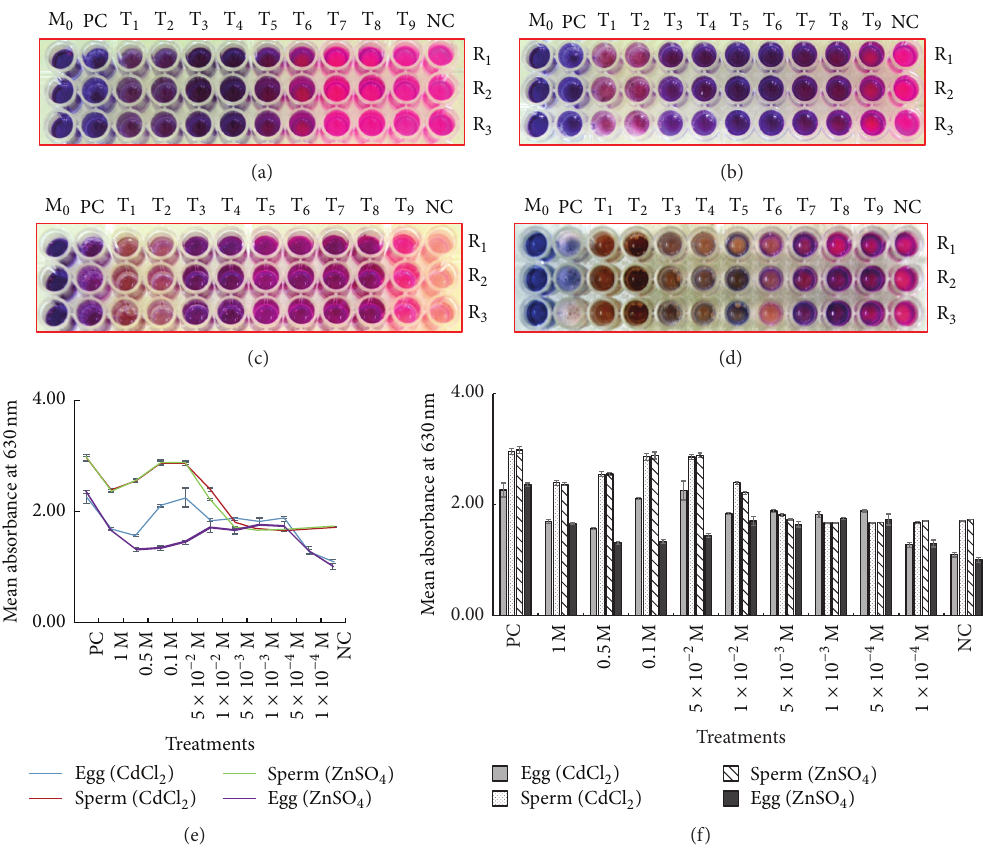
Figure 1: Results of RRT performed on T. gratilla sperm cells treated with (a) CdCl 2 and (b) ZnSO 4 , and egg cells (c and d) treated with the same heavy metal solutions, respectively. M 0 (media control), PC (positive control), T 1 (1M), T 2 (0.5 M), T 3 (0.1M), T 4 (5 × 10 −2 M), T 5 (1 × 10 −2 M), T 6 (5 × 10 −3 M), T 7 (1 × 10 −3 M), T 8 (5 × 10 −4 M), T 9 (1 × 10 −4 M), and NC (negative control). R 1 –R 3 are the replicate wells. (e) Mean absorbance at 630 nm of the wells containing T. gratilla gametes with CdCl 2 and ZnSO 4 treatments after 30 mins of incubation with resazurin. (f) A histogram showing the mean absorbance at 630 nm of the wells containing T. gratilla gametes with CdCl 2 and ZnSO 4 treatments after 30 mins of incubation with